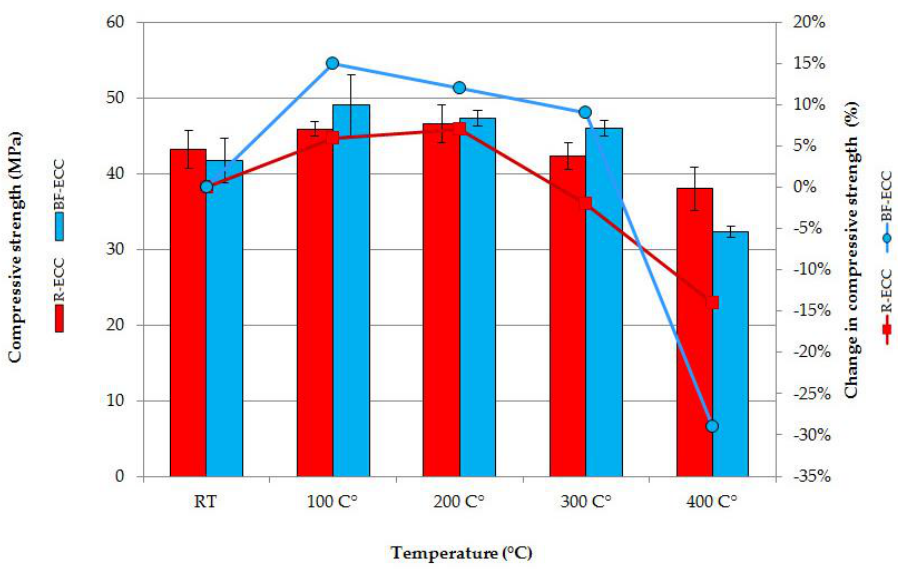
Figure 4. The result of the change in compressive strength of fiber-reinforced and fiber-free fibrous specimens exposed to elevated temperatures up to 400 °C.